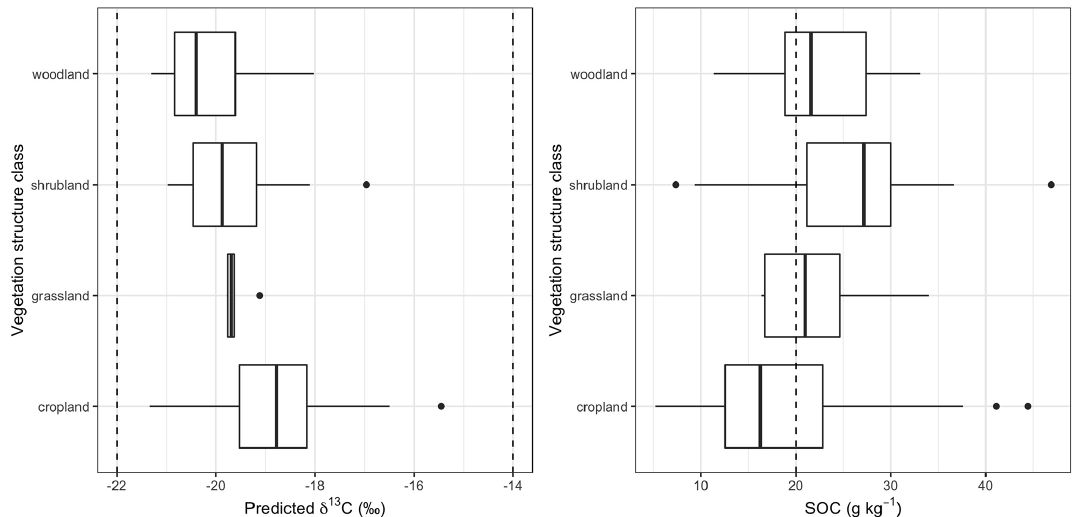
Figure 6. Box plots of δ 13 C values and SOC content in topsoil for each vegetation structure class at the Kayonza and Nyagatare LDSF sites, Rwanda. Dotted vertical lines at − 22‰ and − 14‰ δ 13 C indicate the C3- and C4-dominated systems, respectively. The dotted line at 20gkg − 1 SOC is to indicate a threshold for agricultural productivity in humid